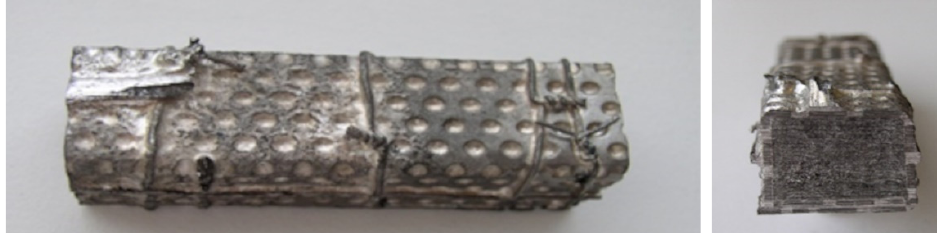
Figure 3. The infiltrated fibrous preform ( left ) and cross-section of the infiltrated fibrous preform ( right ).